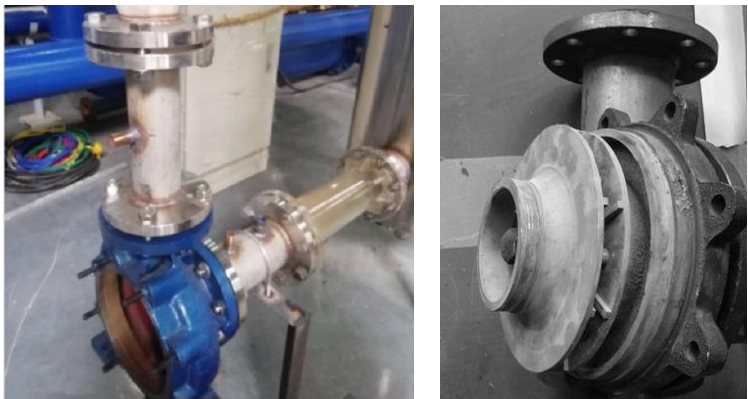
Figure 5. TBD pump casing ( left ) and impeller ( right ).